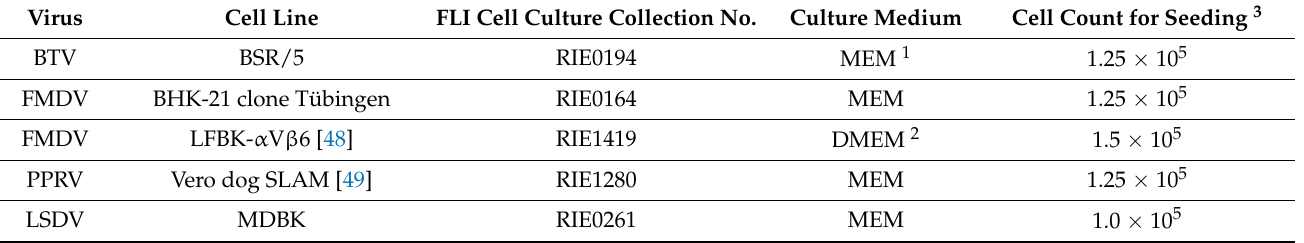
Table 1. Cell lines and media used for virus